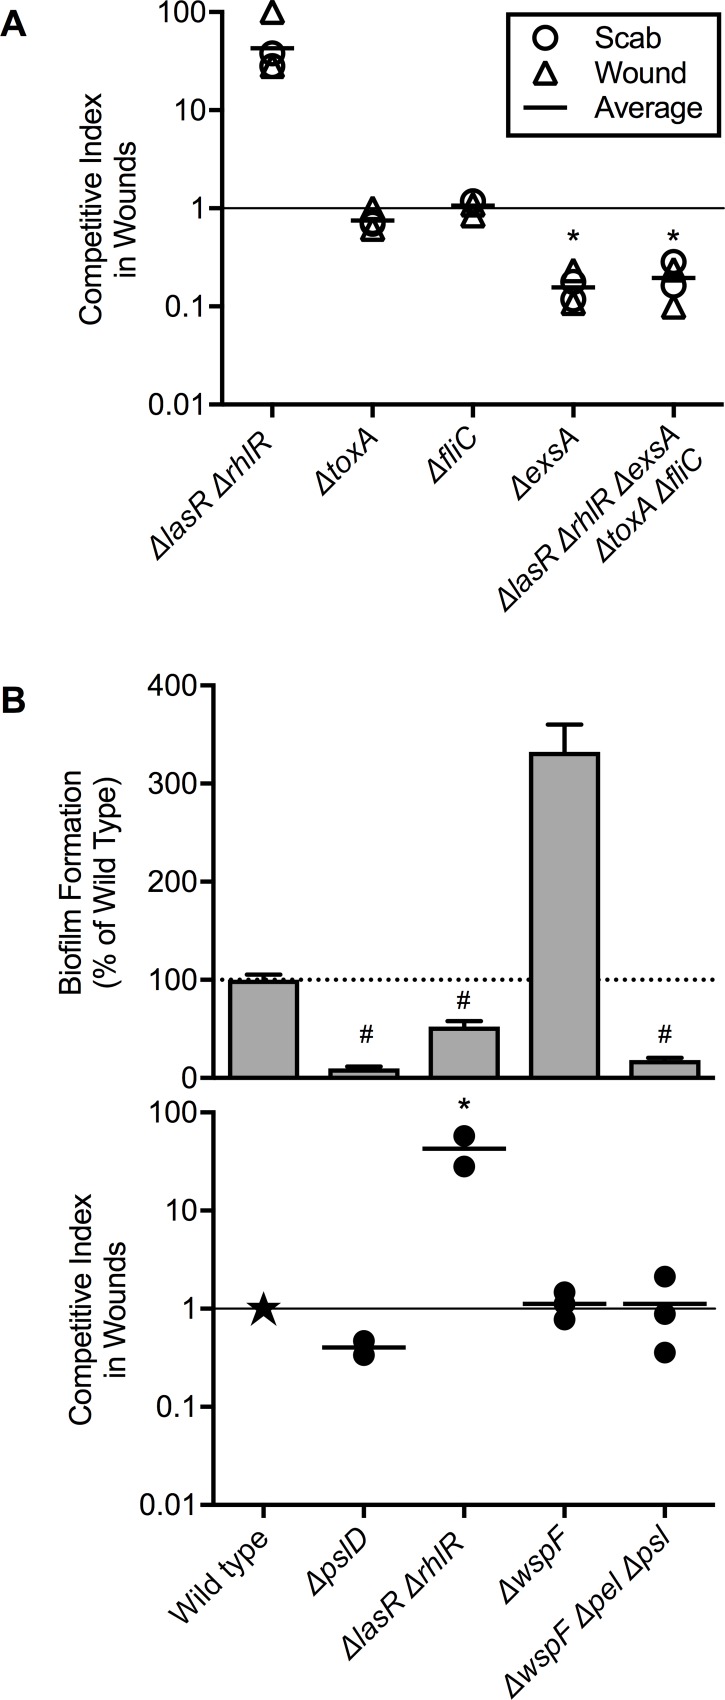
Loss of acute virulence and biofilm formation functions does not decrease fitness in chronic wound infections.A. Mutants lacking indicated acute virulence genes were competed 1:1 against wild-type P. aeruginosa in murine wounds, and competitive index was measured in scabs (circles) and wound beds (triangles). Line indicates mean values. B. Mutants defective and enhanced in biofilm formation (top) were competed 1:1 against wild-type P. aeruginosa in murine wounds (bottom). Scab and wound bed were harvested together (filled circle). Wild-type P. aeruginosa was assigned a competitive index of 1 (star). * indicates competitive index significantly different than 1 (p<0.01) by one sample t test. # indicates significant difference from wild type (p<0.05) by one-way ANOVA followed by Dunnett’s test.